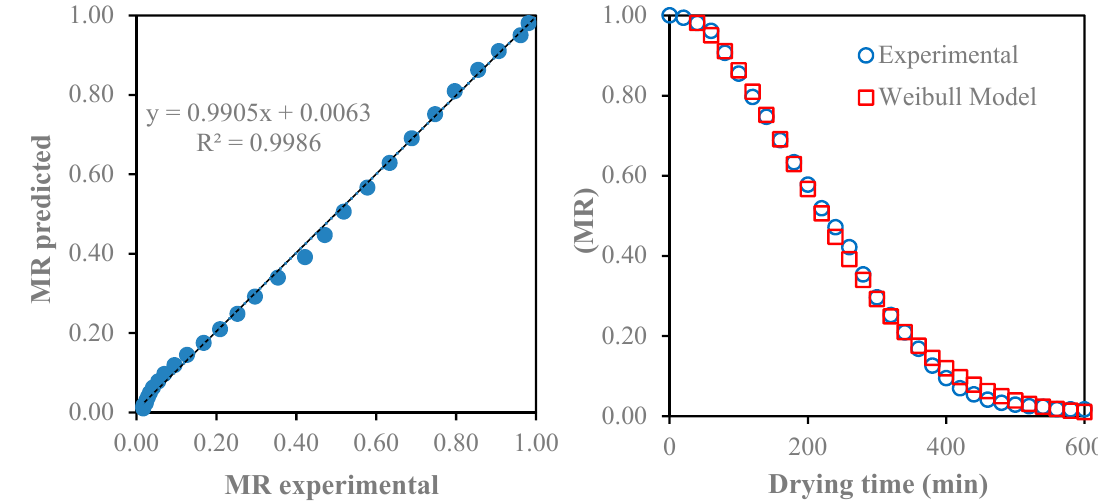
Figure 6. Validation of experimental and predicted moisture ratio values from the Weibull Distribution model.